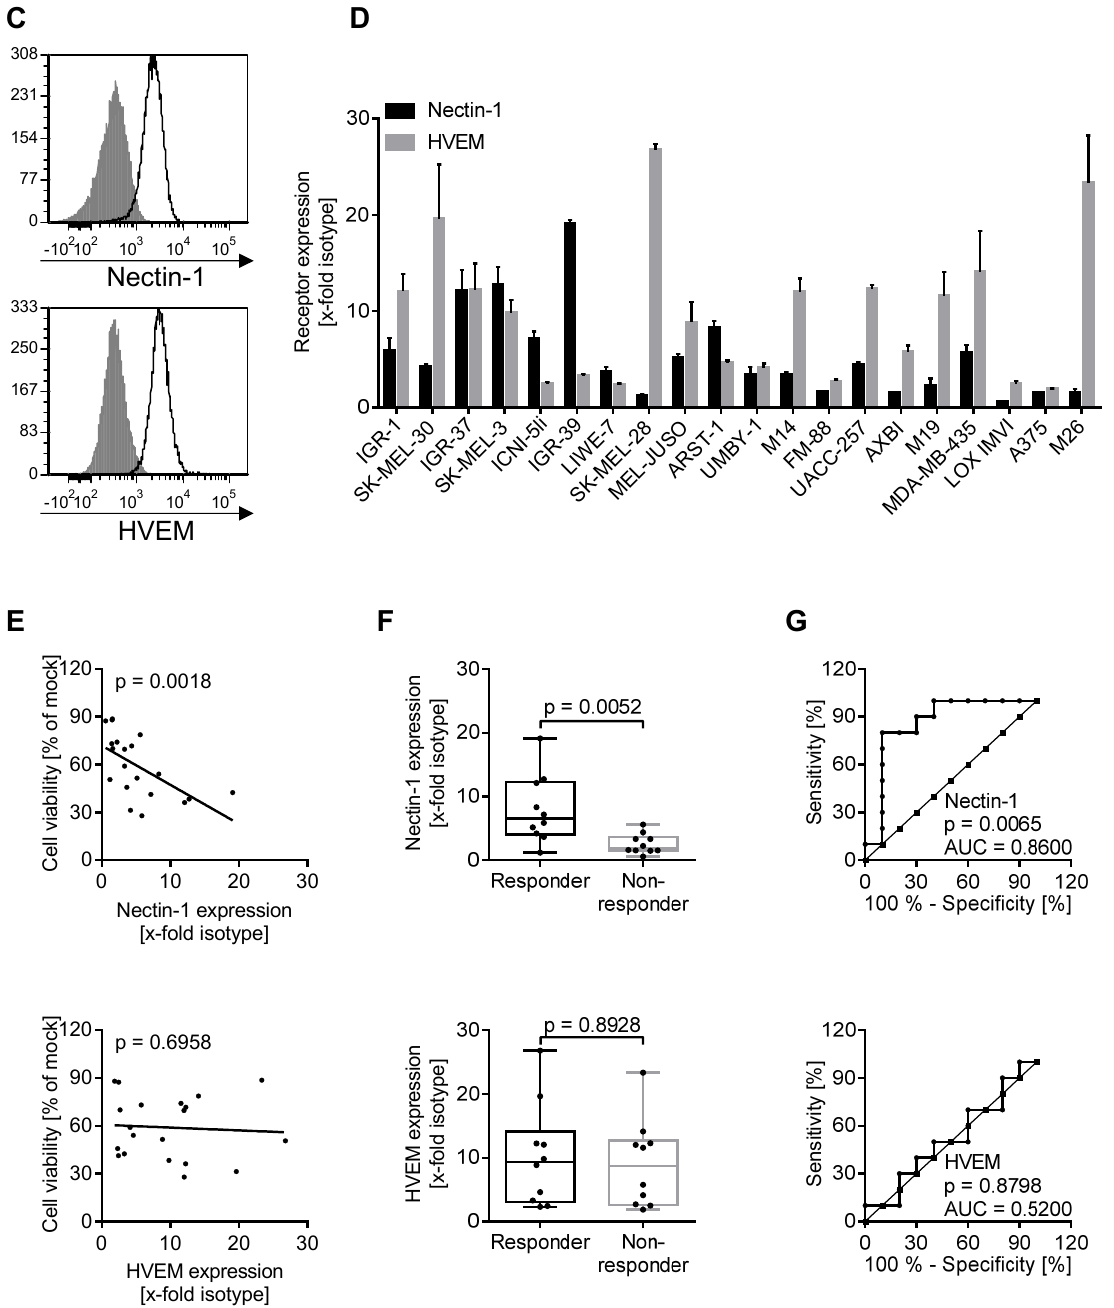
Figure 1. Correlation of the oncolytic activity of herpes simplex virus 1 strain T-VEC with the expression of respective entry receptors on a panel of melanoma cell lines. ( A ) A total of 20 melanoma cell lines were plated in 96-well plates. Cell viability was measured two days after infection with T-VEC (MOI 1) using MTT assay. Data are expressed as viability of uninfected cells (mock) and show mean and standard error of three separate experiments. ( B ) Classification of melanoma cell lines as responders and non-responders reflecting viability levels upon T-VEC infection below and above 60%, respectively. Box plots show median and interquartile ranges in addition to minimum and maximum values. ( C , D ) Expression of Nectin-1 (HVEC, CD111) and herpes virus entry mediator (HVEM, CD270) using flow cytometry with respect to isotype controls on ( C ) a representative cell line (MEL-JUSO) and ( D ) all melanoma cell lines. Results represent mean and standard error of three independent experiments. ( E ) Spearman correlation coefficient, ( F ) box plot, and ( G ) ROC curve analyses of all responder and non-responder cell lines with respect to Nectin-1 (upper part) and HVEM expression (lower part) and corresponding susceptibility to T-VEC induced cell death. p values for box plots were calculated using the Mann–Whitney test; ROC curves analyzed the area under the curve (AUC).